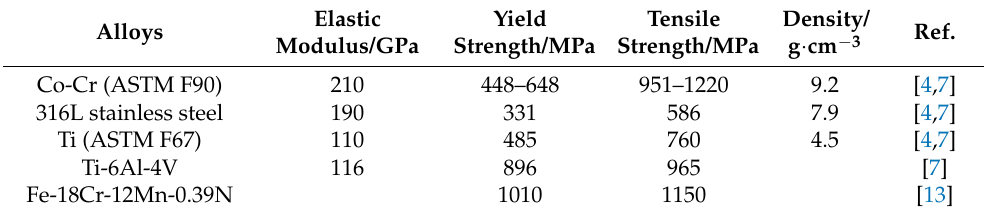
Table 1. Mechanical properties of stainless steel, titanium, and Co-Cr alloys. Elastic Yield Alloys Modulus/GPa Strength/MPa